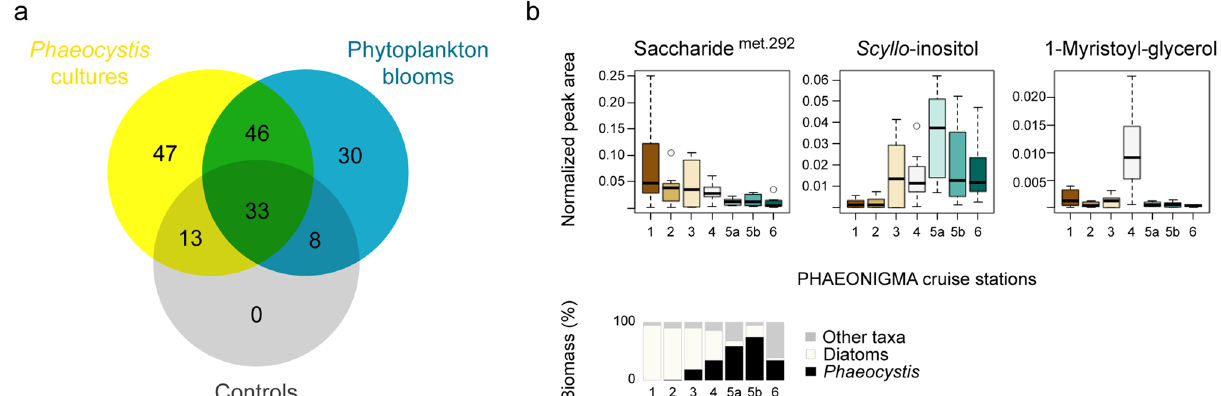
Figure 4. Occurrence of Phaeocystis pouchetii endometabolites within natural phytoplankton communities of the Barents Sea and North Norwegian fjords. ( a ) Venn diagram of unique and shared metabolites between P. pouchetii laboratory cultures (n = 12), natural phytoplankton communities (n = 58), and controls (n = 7). ( b ) Box-Whisker plots showing abundance of selected shared metabolites (as peak area/peak sum) at Barents Sea (1–3) and North Norwegian fjord stations (4–6; n = 8–9, averaged over all depths). The geographic locations of the cruise stations are depicted in Fig. 5a. The depicted metabolites are representative for three occurrence patterns: diatom dominance (station 1–3), Phaeocystis dominance (station 5–6), and nutrient depletion (station 4) as indicated by the relative biomass of phytoplankton taxa at the respective